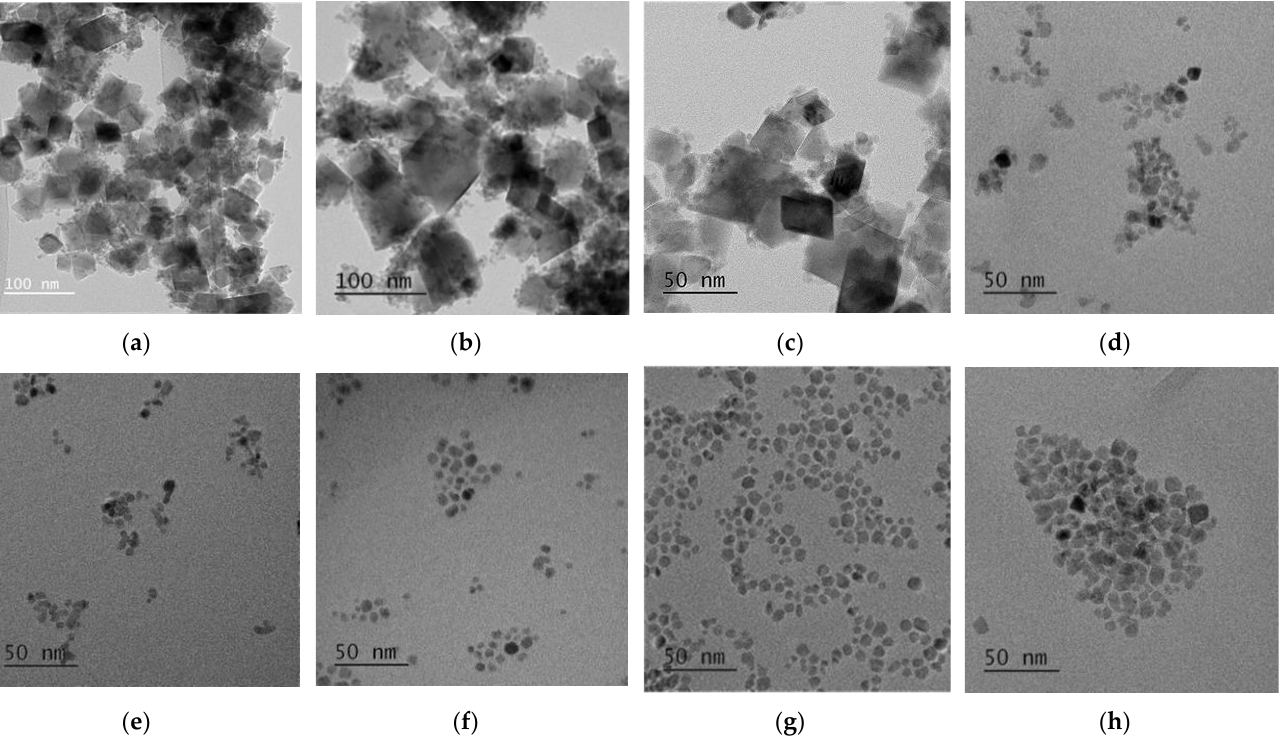
Figure 8. TEM results of cobalt ferrite nanoparticles synthesized at 180 °C for 16 h with different oleic acid concentrations of 0 M ( a ), 0.025 M ( b ), 0.05 M ( c ), 0.1 M ( d ), 0.15 M ( e ), 0.5 M ( f ), 1 M ( g ), and 1.5 M ( h ).